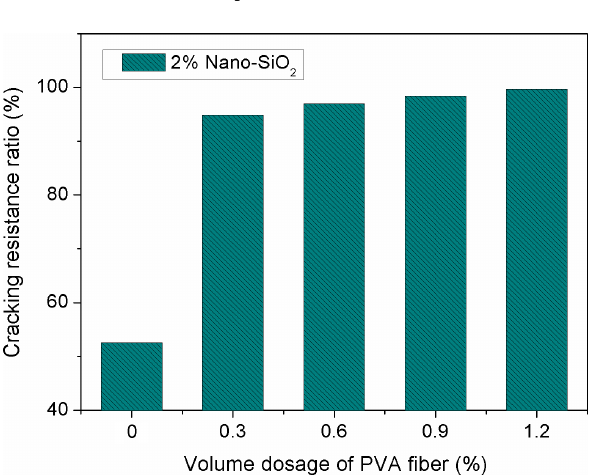
Figure 4: Effect of PVA fiber on cracking resistance ratio